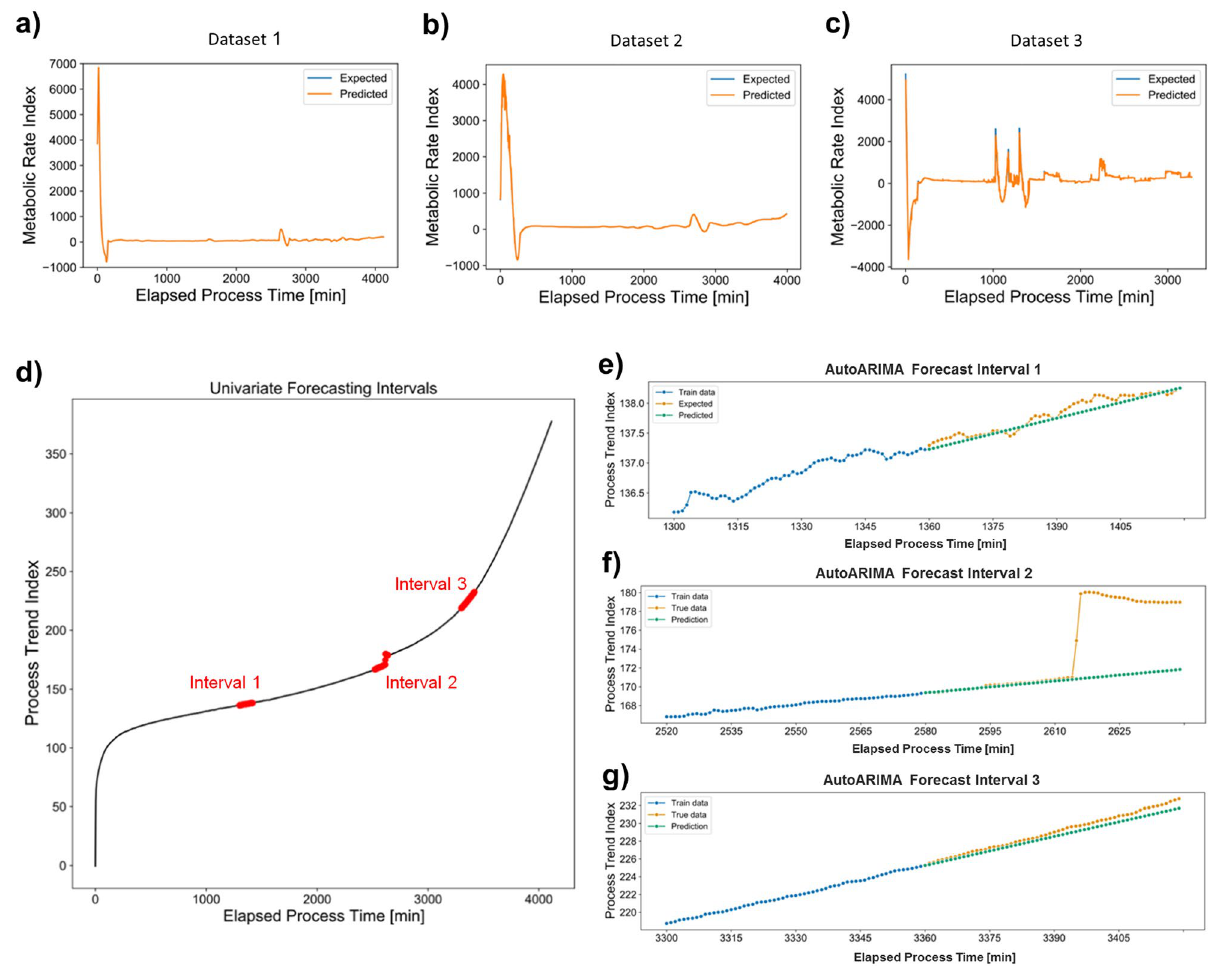
Figure 7. ( a ), ( b ), ( c ) XGBoost Regression models trained and tested on individual datasets. ( a ) RMSE: 12.16, Training set size: 75%. ( b ) RMSE: 29.53, Training set size: 50%. ( c ) RMSE: 102.11, Training set size: 25%. ( d ) PTI curve of ‘unoptimised’ process 1 with the three test intervals for univariate forecasting delineated. ( e ), ( f ), ( g ) AutoARIMA forecasts for the three test intervals. Models were trained on data from the past 60 min and forecasted the next 60 min. RMSEs for entire 60 min forecasts: ( e ) 0.099, ( f ) 5.116, ( g )